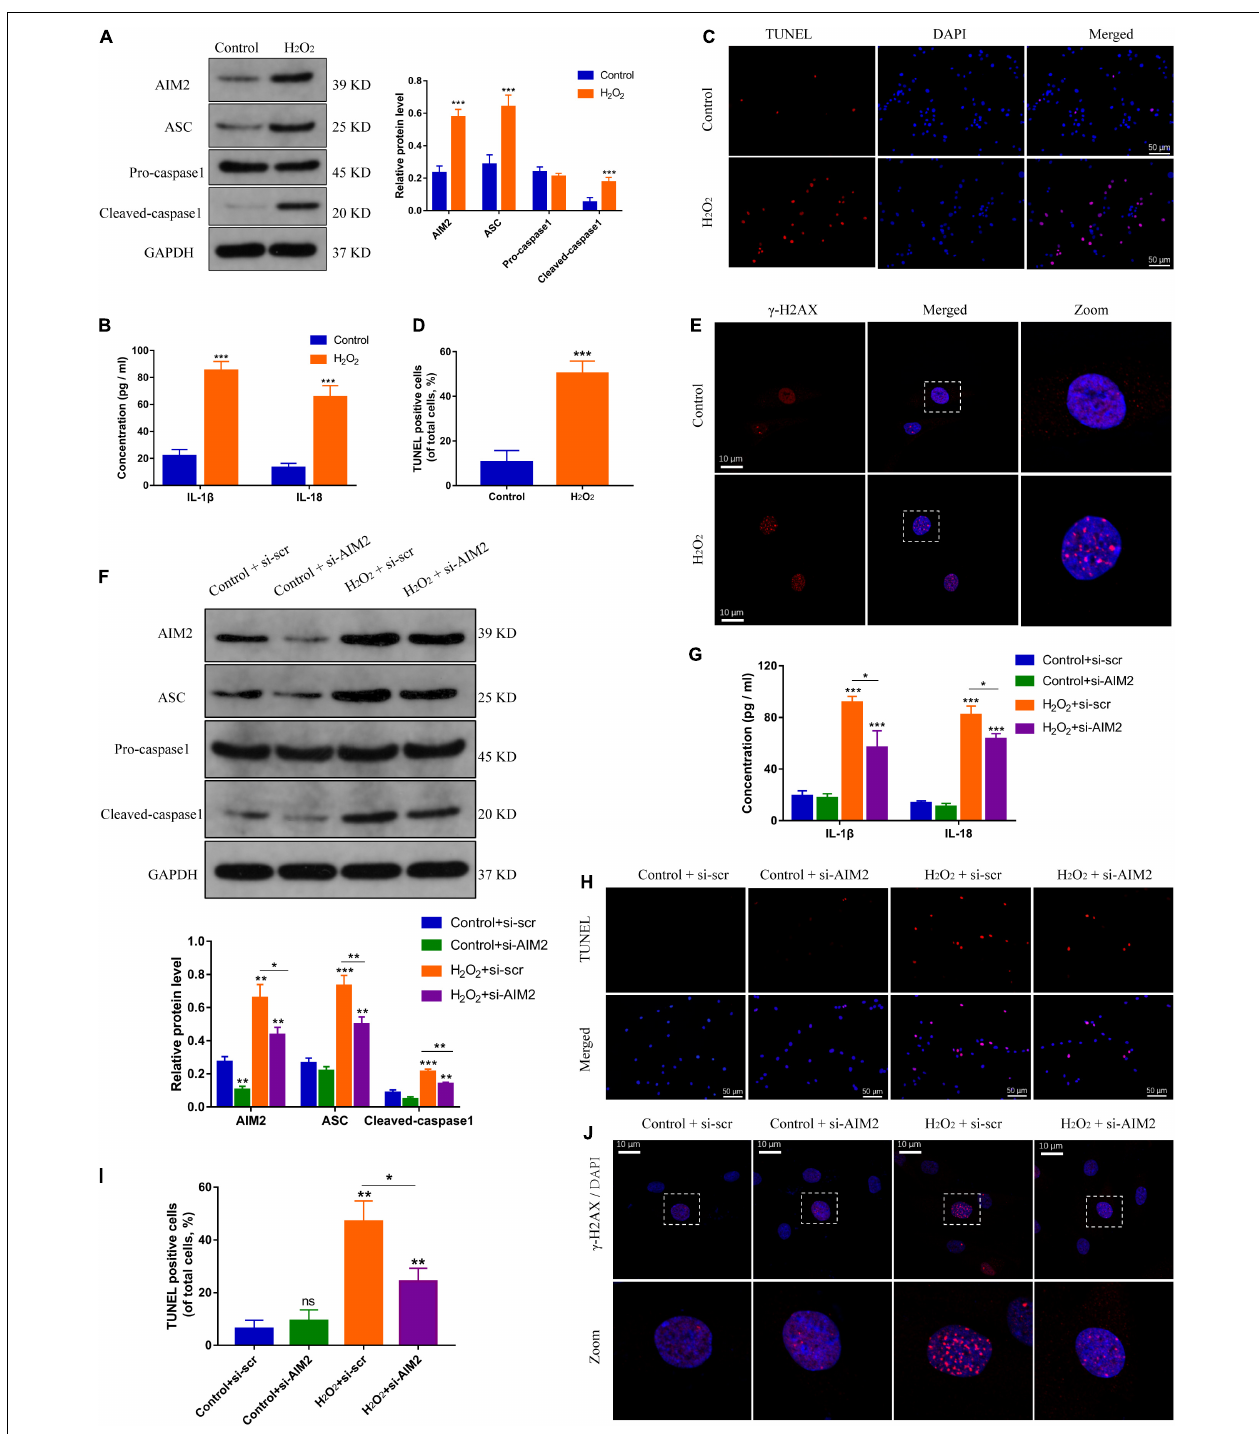
FIGURE 2 | Silencing of AIM2 ameliorates DNA damage in NP cells in vitro . (A) Protein levels and quantification of AIM2, ASC, pro-caspase-1, and cleaved caspase-1 in H 2 O 2 -treated (200 µ M, 8 h) NP cells. NP cells in the control group were treated with equivalent solvent. (B) Extracellular level of IL-1 β and IL-18 measured by ELISA. (C,D) TUNEL analysis of H 2 O 2 -treated NP cells (C) and corresponding quantification of cell apoptosis (D) . (E) Immunostaining of γ -H2AX in H 2 O 2 -treated NP cells. Data were presented as the means ± SD. * P < 0.05, ** P < 0.01, *** P < 0.001 vs. control group. (F) Protein levels and quantification of AIM2, ASC, pro-caspase-1, and cleaved caspase-1 in H 2 O 2 -treated NP cells co-treated with si-AIM2 or si-scr. (G) Extracellular level of IL-1 β and IL-18 measured by ELISA. (H,I) Represent images of TUNEL analysis (H) and evaluation of cell apoptotic rates (I) . (J) Immunostaining of γ -H2AX in H 2 O 2 -treated NP cells co-treated with si-AIM2 or si-scr. * P < 0.05, ** P < 0.01, *** P < 0.001 vs. control-si-scr group, n = 3.